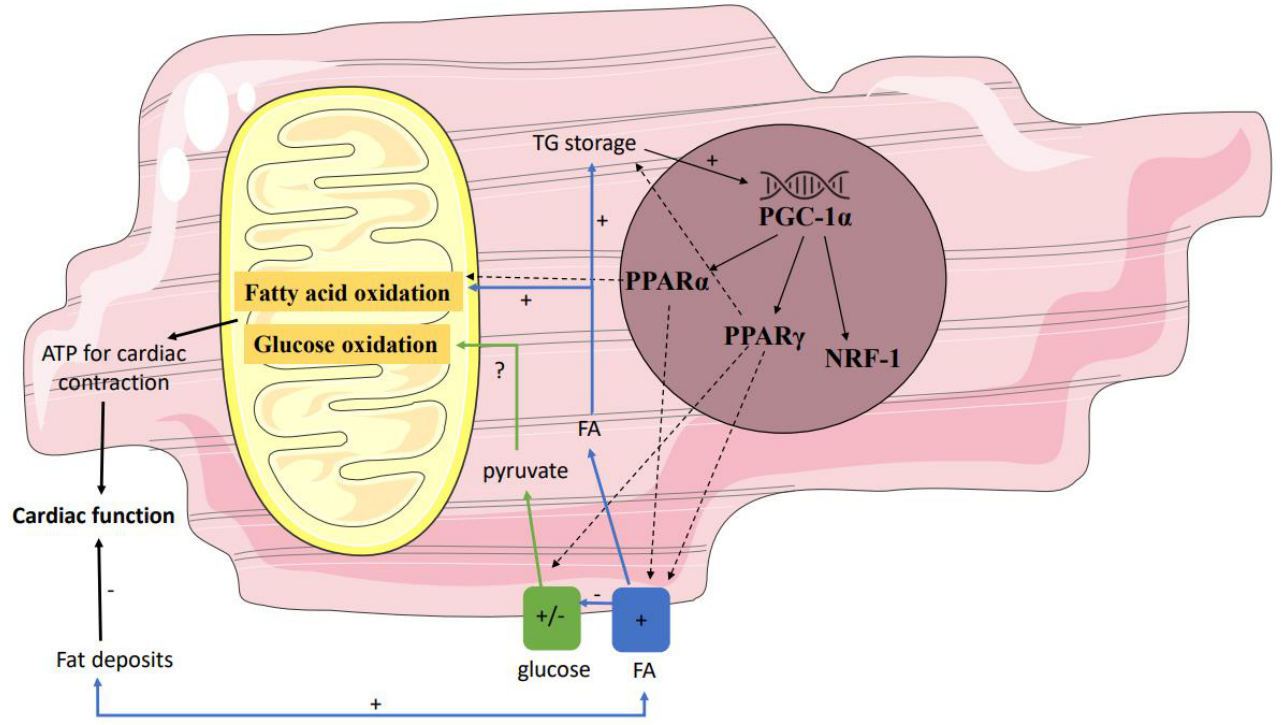
Figure 2. Gene regulatory pathways affecting mitochondrial function. Several genes influence the interplay between the supply and oxidation of the various substrates. Down- and/or upregulation of these genes in prediabetes may affect mitochondrial function. Partly because of this, in prediabetes fatty acid oxidation may be stimulated, resulting in a net reduction in ATP and thus reduced myocardial efficiency. PPAR peroxisome proliferator-activated receptor; ATP adenosine